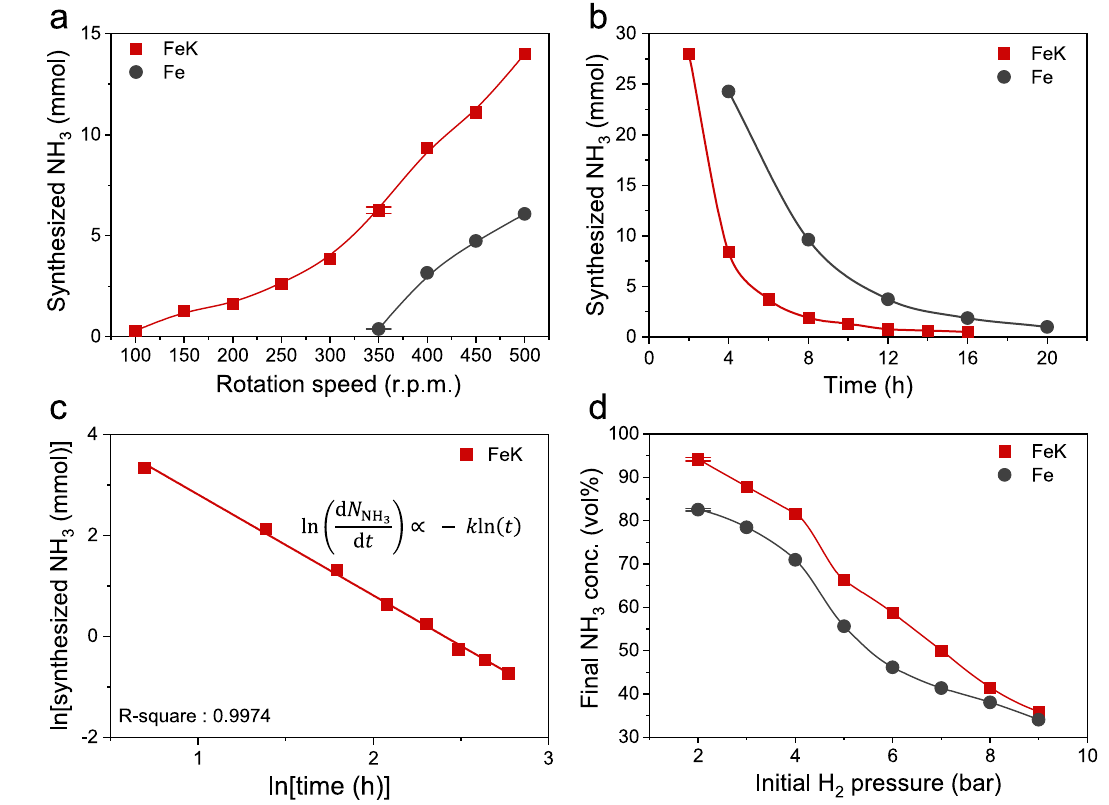
Fig. 3 | Ammoniayield kinetics. a The amountof synthesizedNH 3 versus rotation speed. The N 2 absorbed FeK powders were prepared by ball-milling in N 2 pressure (9bar)for18h.ThetotalnumberofrotationcyclesforFeKwere60,000,andforN 2 absorbed Fe were 120,000. Data were normalized to 30,000 cycles (at 500 r.p.m. for 1h). b The amount of synthesizedNH 3 versus time, which is the hydrogenation rate at the rotation speed of 500 r.p.m. for both FeK and Fe. Hydrogenation was repeatedafterchargingH 2 pressure(9bareach)every2hforFeK,andevery4hfor